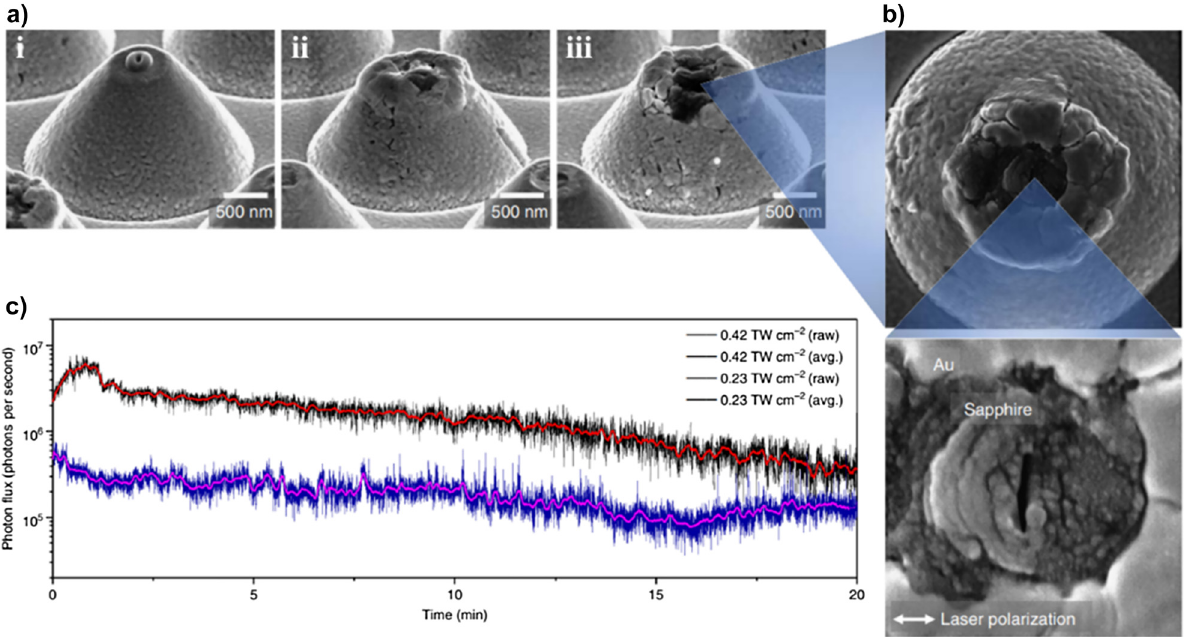
Figure 12: Laser-induced damage in plasmonic nanostructures. (a)SEMimageofthelaser-induceddamageinanAu-Sapphirefunnelstructureforanincidentintensityof(i)0.23,(ii)0.42,and(iii)0 . 66 × 10 12 W/cm 2 . (b) Magni fi ed top view of a deformed Au-Sapphire funnel structure for 0 . 66 × 10 12 W/cm 2 . (c) Time-dependent variation of the XUV photon fl ux (H7, H9, H11, and H13) from an Au-sapphire funnel structure at two different input laser intensities